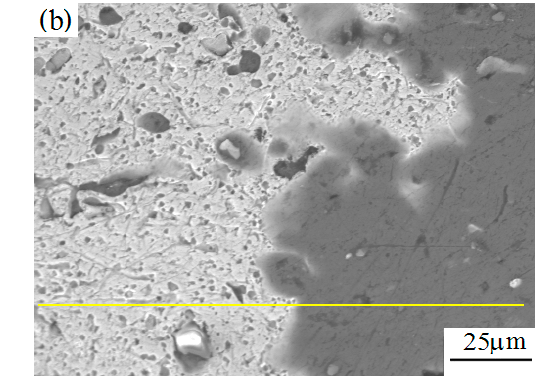
Figure 3. Microstructure of the transition zone of alloy ingots of the Al–50Pb system in ( a ) the initial state and ( b ) after EMP treatment. The light field is the aluminum phase, and the dark field is the lead phase.